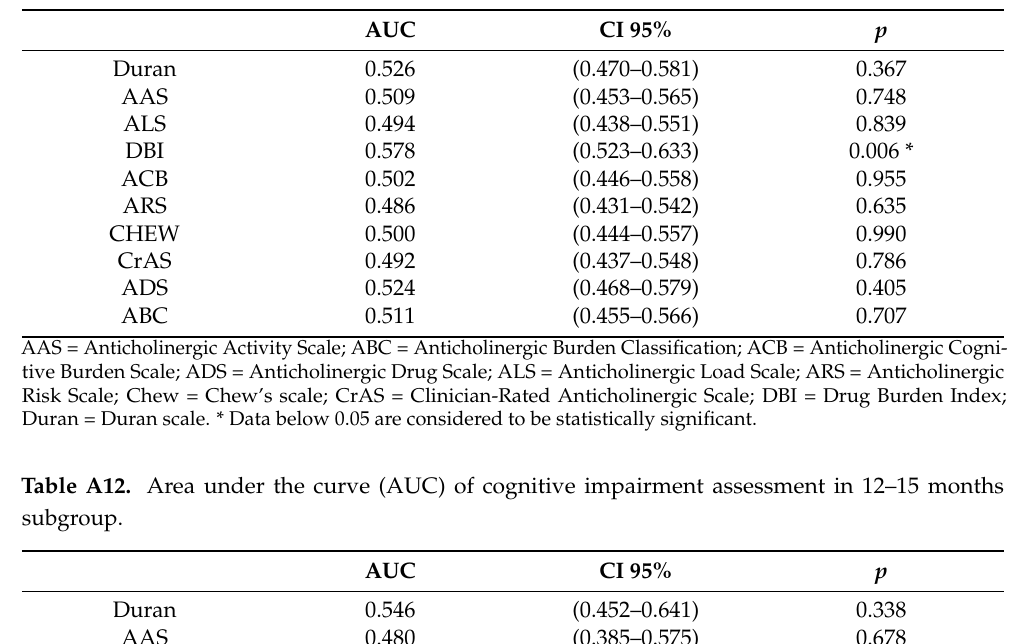
Table A11. Area under the curve (AUC) of cognitive impairment assessment independent of time of assessment.